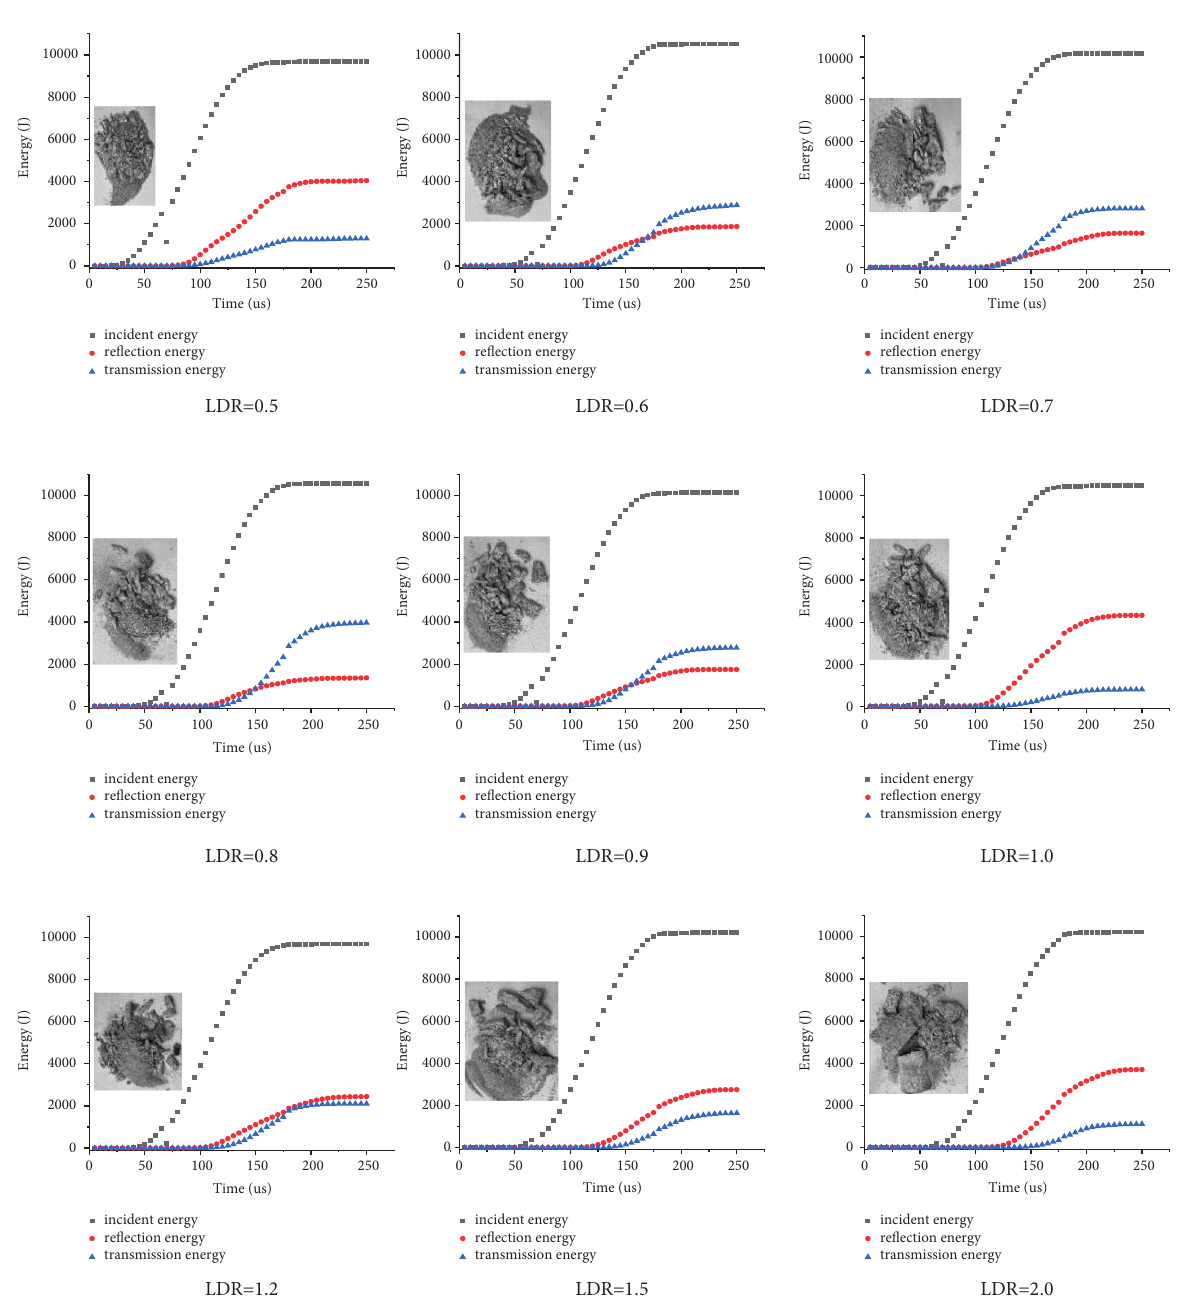
Figure 4: Different energy time history curves of different length-to-diameter ratios of granite